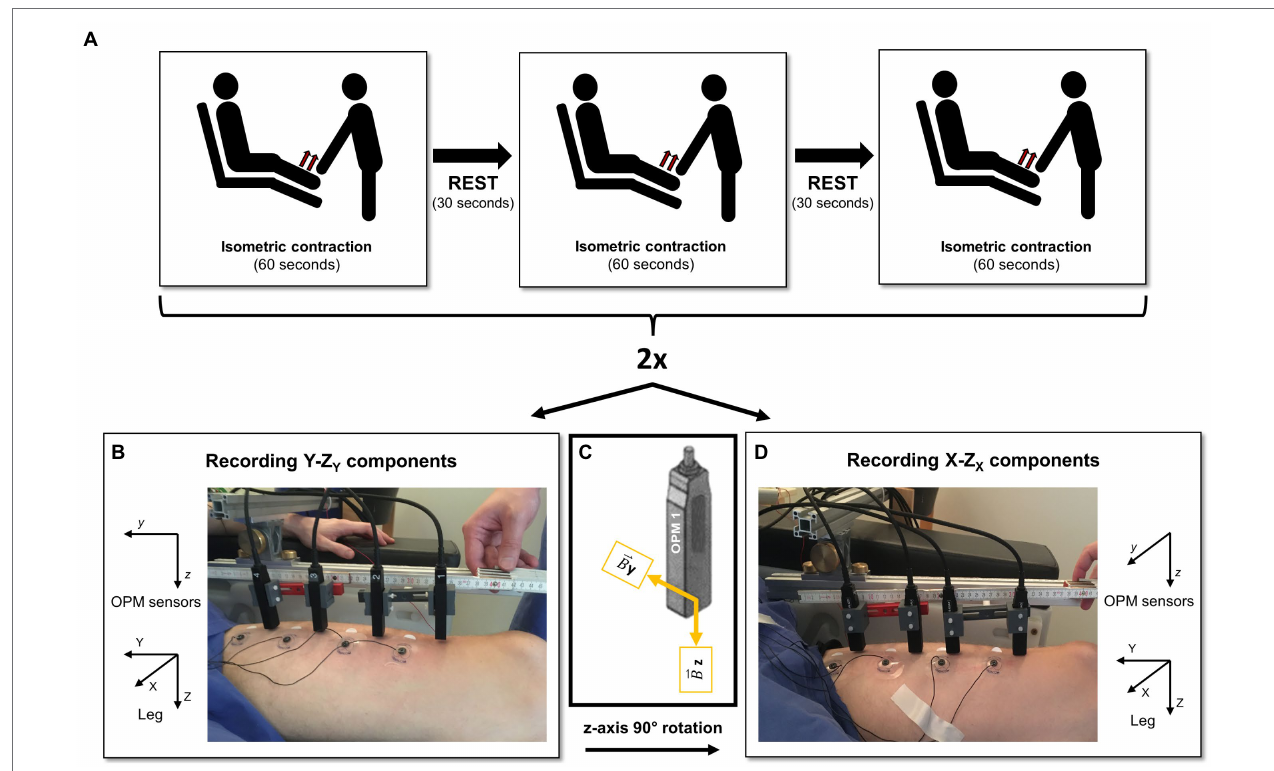
FIGURE 1 | Experimental setup. (A) Experimental design. (B) Experimental setup during the recording of the Y and Z Y components, with reference to the reported leg coordinates system. (C) The utilized optically pumped magnetometer (OPM) sensors could record only two components per time ( y and z ); therefore, they were rotated by 90 ° around the z-axis to also record the signal of the X component. (D) Experimental setup during the recording of the X and Z X spatial components, referred to the reported leg coordinates system. Note here the different orientation of the